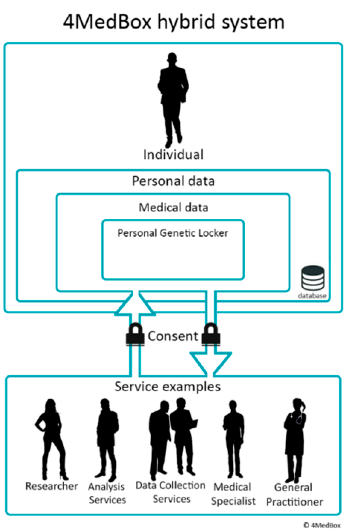
Figure 1. The interaction in the 4MedBox system between an individual and examples of possible medical services an individual can use. The image visualizes control over the data by the individual by giving consent.